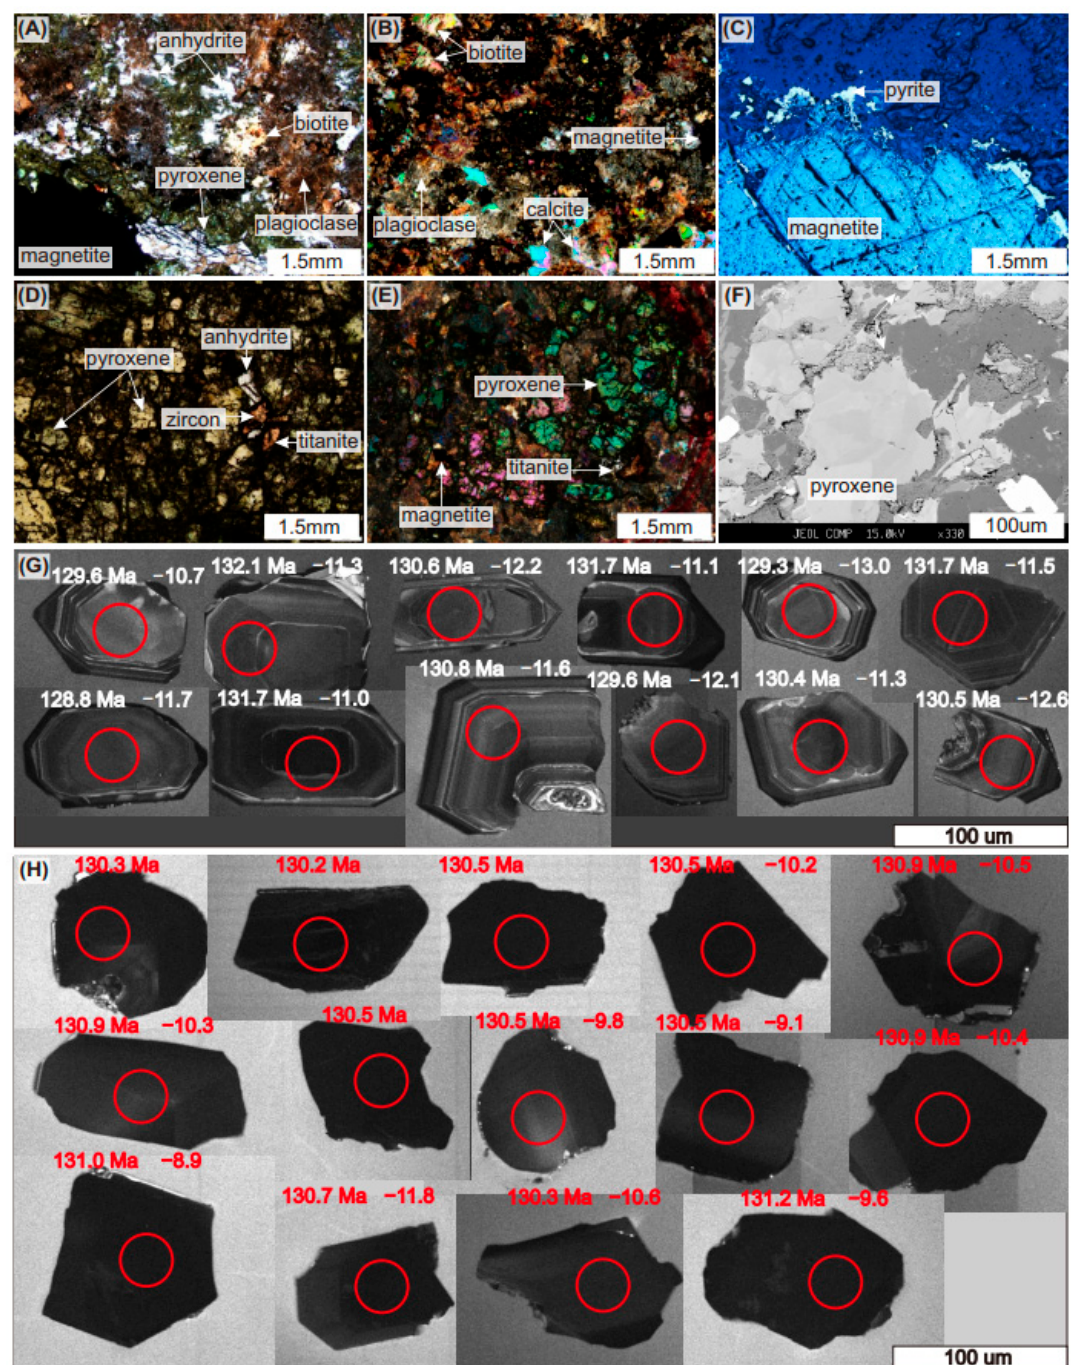
Figure 4. Representative photomicrographs and zircon characteristics of diorite porphyry from the Nihe IOA deposit. The phenocrysts in the diorite porphyry are mainly plagioclase, pyroxene, and biotite ( A , B ), and they are closely associated with magnetite. Some pyrite develops around and/or cuts the magnetite ( C ). Zircon occurs in the titanite that is spatially associated with anhydrite ( D ), suggesting that zircon and titanite are of hydrothermal origins. Clinopyroxene is the most important gangue mineral at Nihe ( D , E ), and the clinopyroxene has approximate zones in BSE images ( F ). Zircons from ZK0114-1130 have prominent oscillatory zones ( G ), while zircons from ZK0101-667 show inconspicuous oscillatory zones and core-rim structures ( H ). The U–Pb ages and ε Hf (t) values of these zircons are shown in panels G and H.